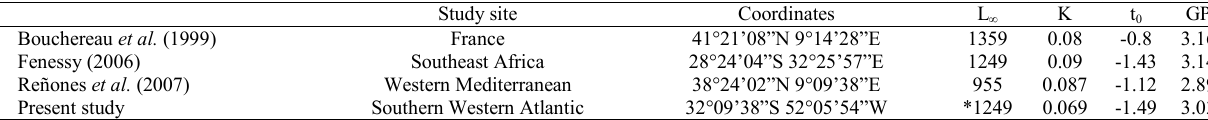
, t and K parameters and the growth performance (GP) value obtained for 4 0 obtained from Fenessy 4